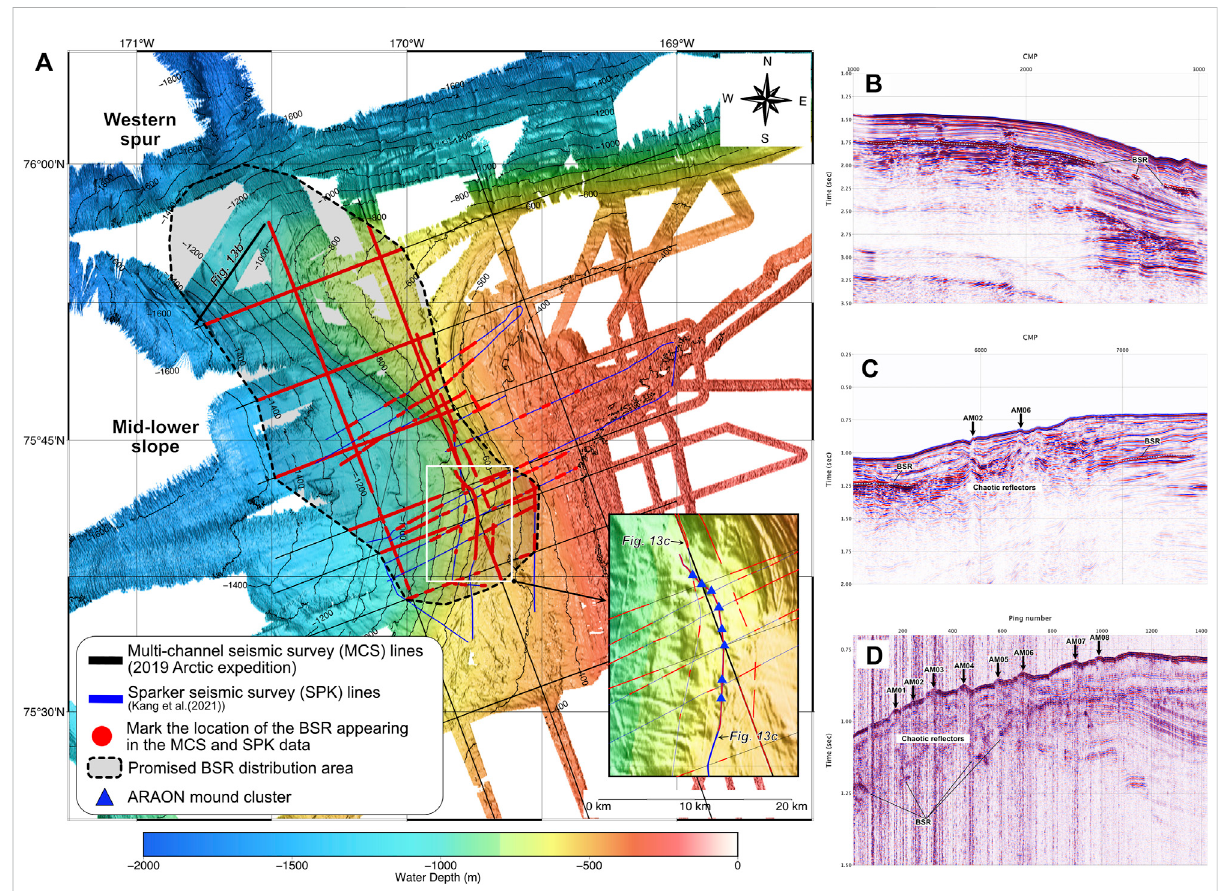
FIGURE 13 (A) Distribution map of the BSR in the western continental margin of the Chukchi Rise. (B) – (D) are the MCS and sparker seismic images: (B) migrated seismic images of the MCS03T transit line, (C) migrated seismic images of the MCS02 line, and (D) seismic images of the ES_SP004 line modi fi ed from Kang et al.